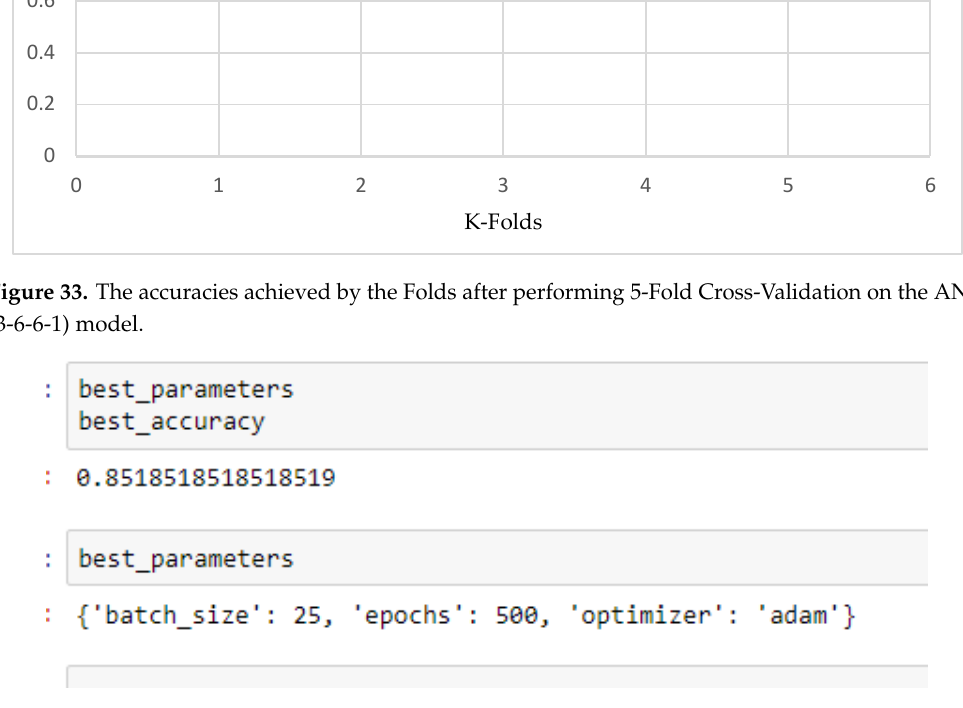
Figure 34. The best parameters with obtained after performing grid search with 5-Fold Cross-Validation on the ANN (3-6-6-1) model.